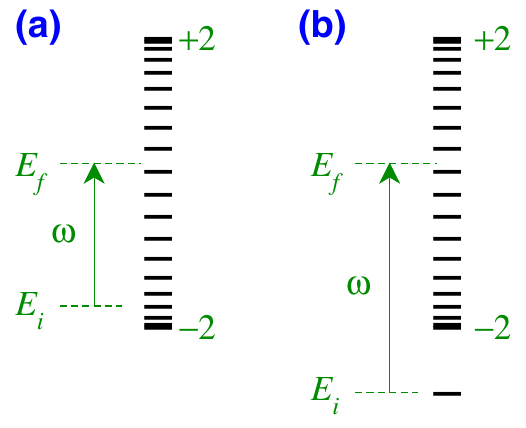
Figure 2 . (Color online) Two scenarios of transition in the peri- odically driven one-dimensional tight-binding model. (a) Continuum-to-continuum transition. The initial state is an eigen- state, i.e., a Bloch state, of the perfect model (11). (b) Bound-to- continuum transition. The unperturbed Hamiltonian (13) contains a defected site and the initial state is the defect mode. Note that locally speaking, the spectrum of the tight-binding model is almost equally